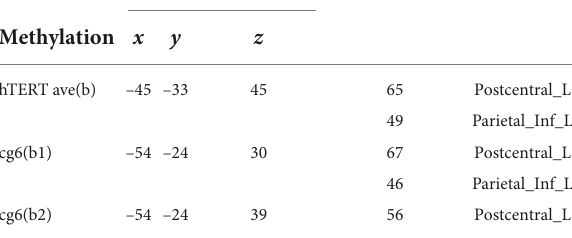
hTERT ave: mean value of hTERT promoter methylation. b1: the significant overlapping clusters that associated with the methylation of cg1295648 and the degree of harm of patients’ social function. b2: the significant overlapping clusters located left postcentral gyrus, that associated with the methylation of cg1295648 and the degree of harm of